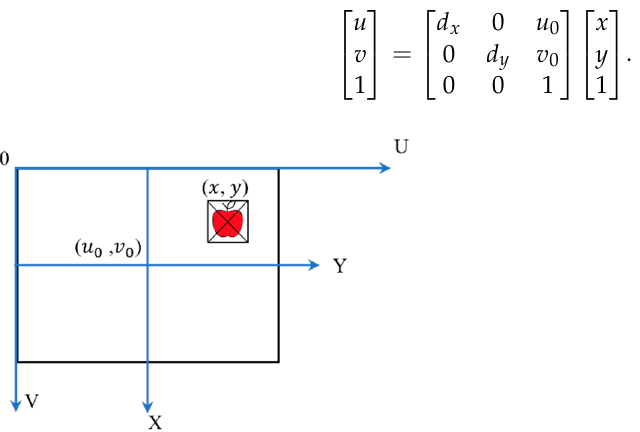
Figure 6. Camera and image coordinates for individual apple localization.